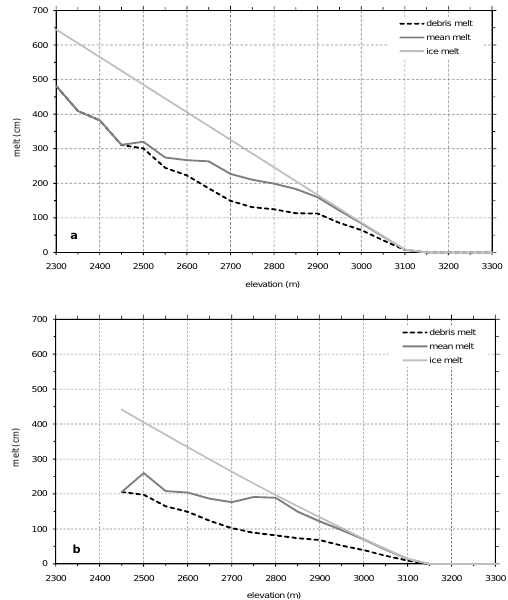
Fig. 12. Model results of net ablation for the two glacier basins and the sample year 2008. (a) Northern test basin (b) Southern test basin, based on a degree day approach and including the effect of supra-glacial debris. For the sub-debris melt, the specific condi- tions documented by our field measurements are used for the entire basin. Temperature information is provided by the glacier AWS on the Djankuat Glacier and a weather station at Ambrolauri in Georgia for the Zopkhito basin